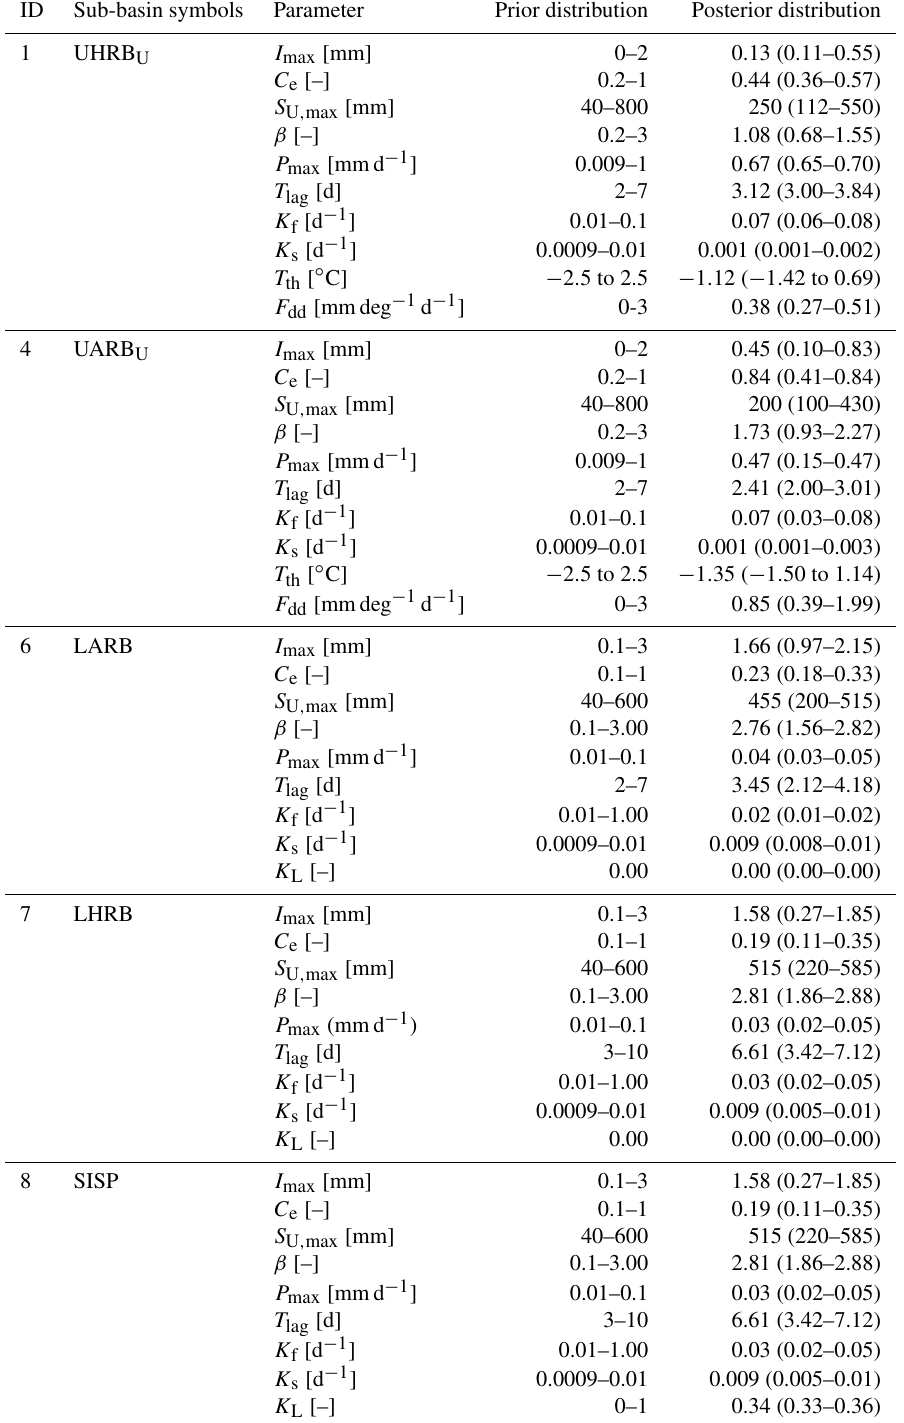
Table 2. Uniform prior and posterior distributions of model parameters for the calibrated models. The posterior column distributions show the parameter values of the best available parameter set as well as the 5th and 95th percentiles of feasible solutions (in brackets). Note that the loss factor K L had negligible influence and was thus set to 0 for the models of ID6 and ID7 to keep to the principle of model